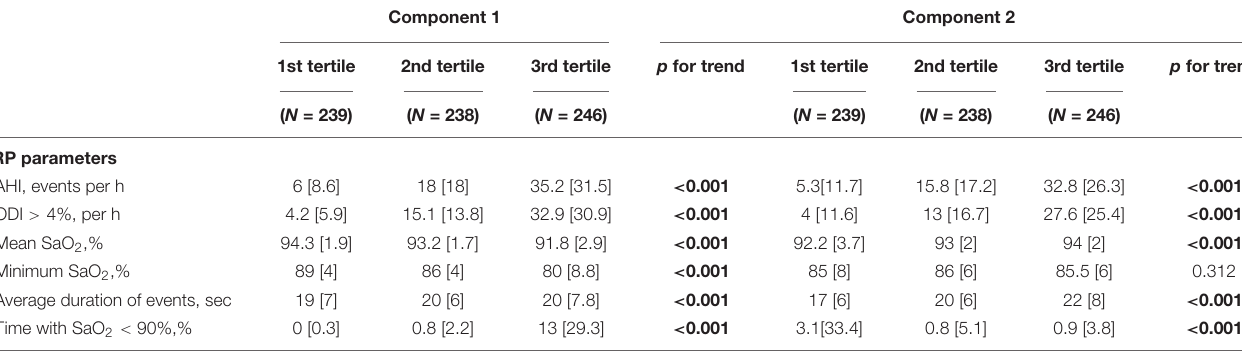
TABLE 2 | Description of the respiratory polygraphy parameters by tertiles of the components derived from the PCA in the ISAACC cohort. Component 1